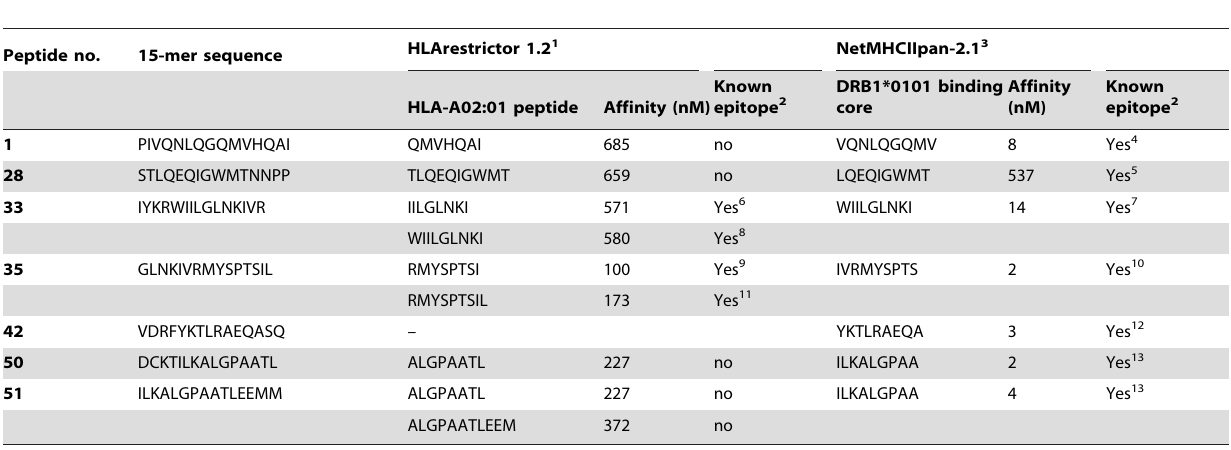
Table 2. Identification of CD4 and CD8 T-cell epitopes within responding 15-mer peptides.